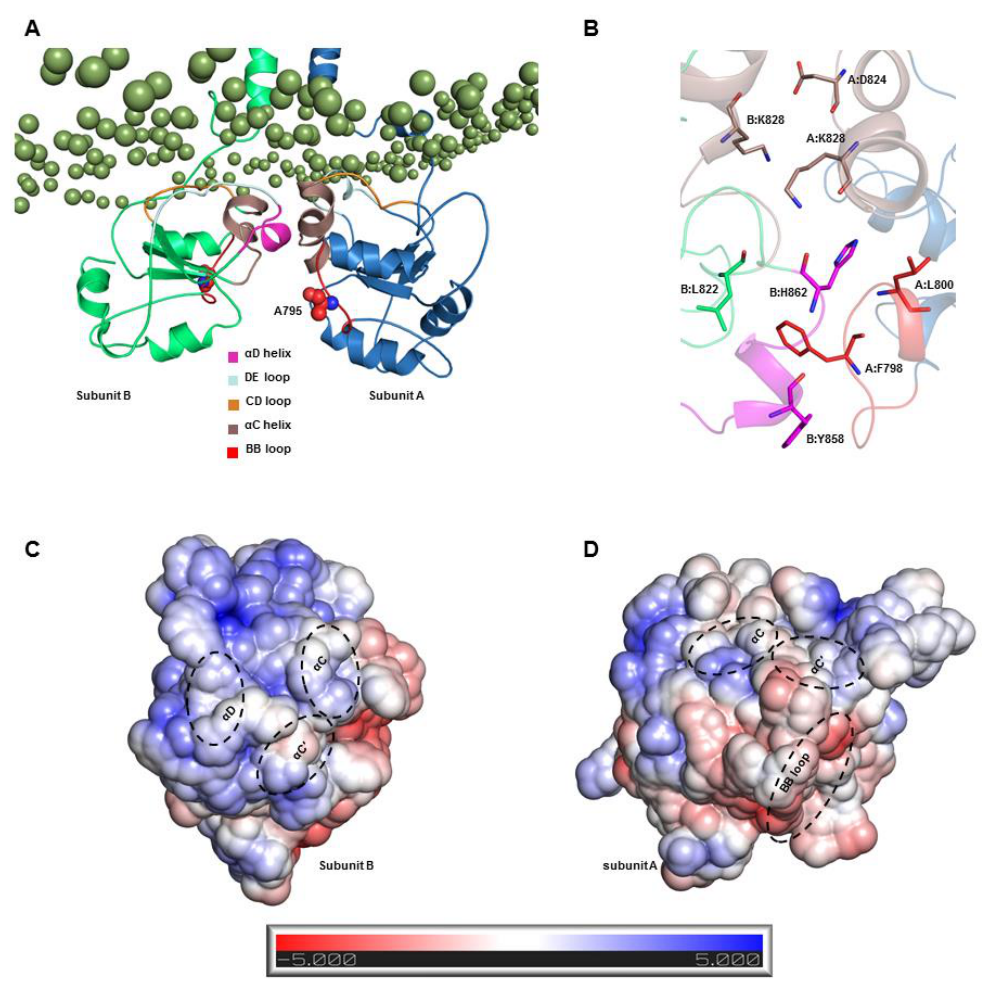
Figure 9. Illustration of the intermolecular interactions and electrostatic properties of the S2-TIR dimerization complex. ( A ) The representative low-energy dimer interface of the S2-TIR domains: The structural elements with significant interactions with either phospholipids or their monomer counterparts are colored di ff erently for clarity. The important BB loop residue, A795, is represented by sphere model in both subunits. ( B ) Zoomed view of the polar and nonpolar interactions occurring at the dimer interface of the S2-TIR domain. ( C , D ) The electrostatic potential surface of the two subunits of the S2-TIR dimer: The location of interfacing segments is indicated with dashed circles.